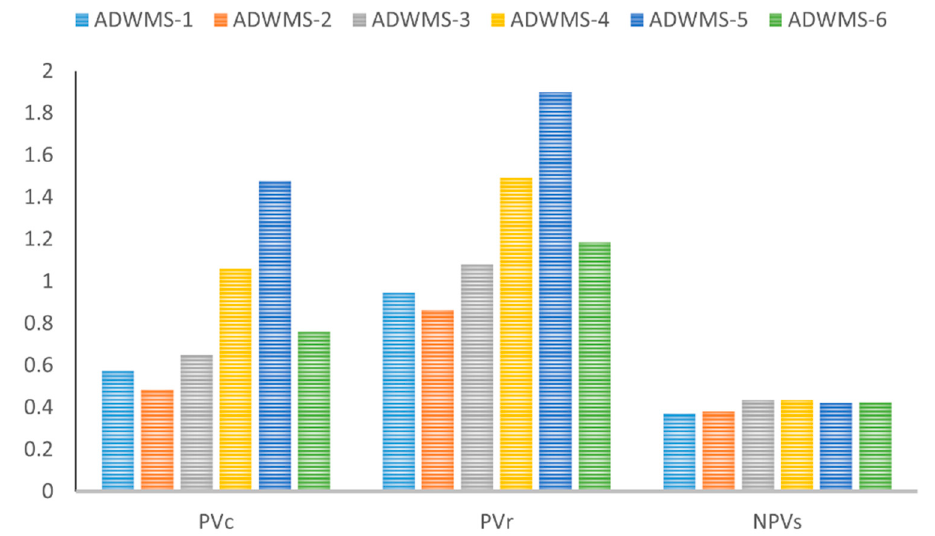
Figure 6. Total NPV for ADWM Strategies.